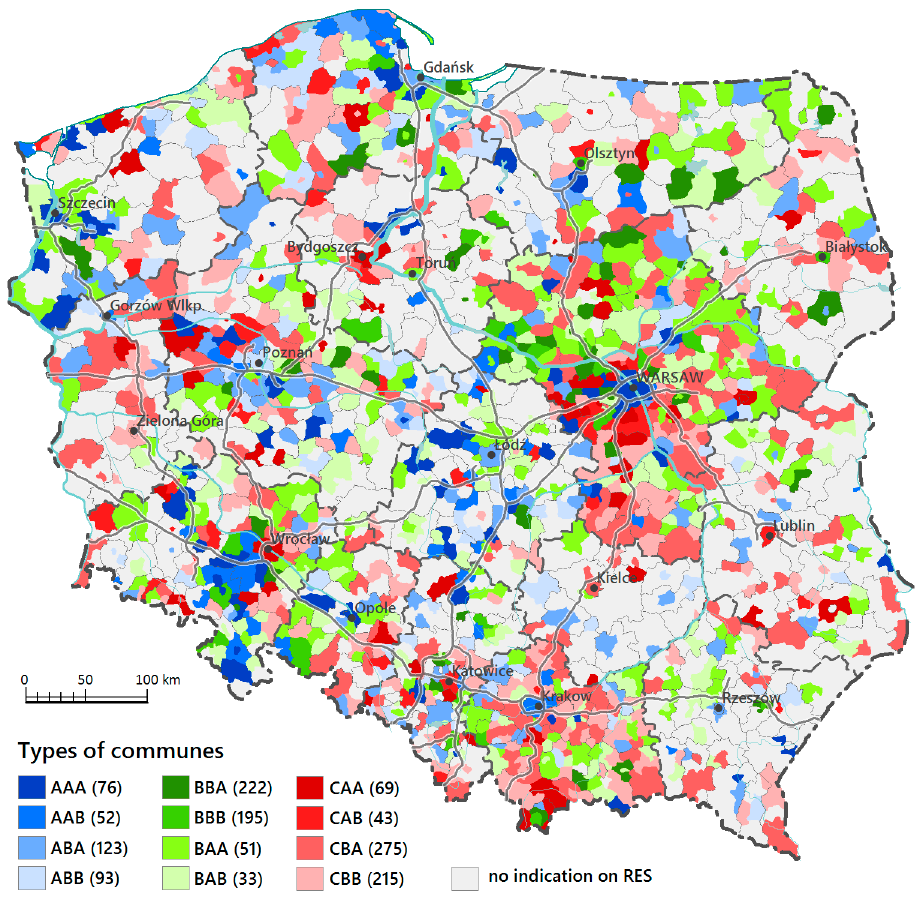
Figure 1. Typology of municipalities in terms of characteristics of municipal (commune) studies for indications of renewable energy sources.